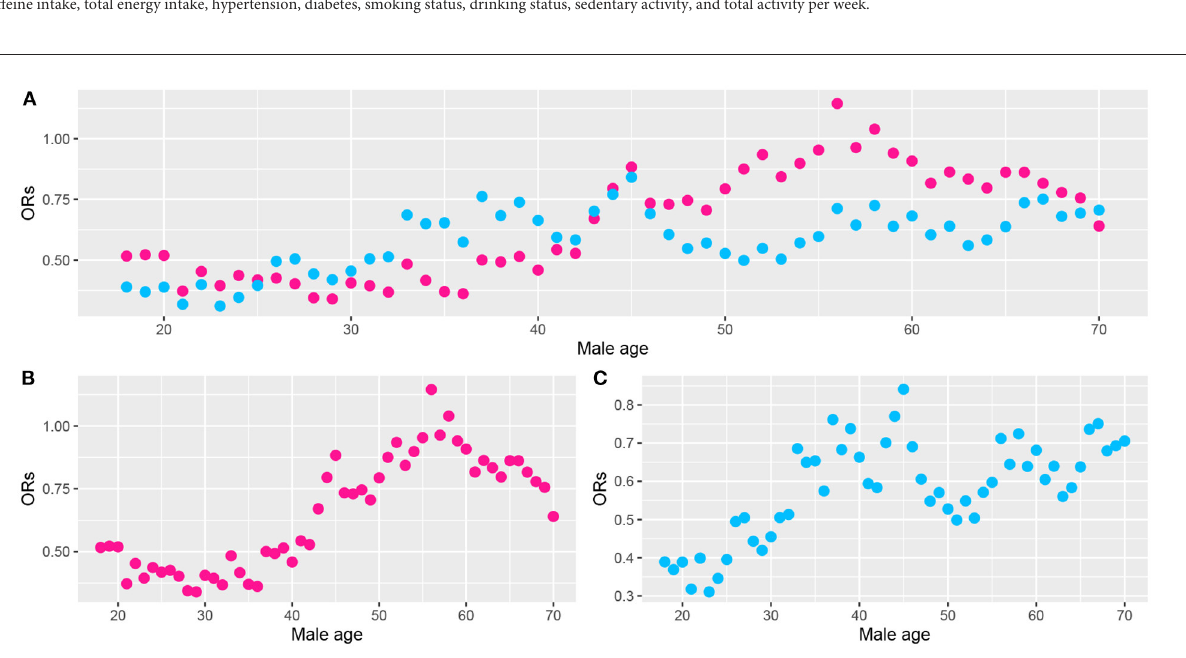
FIGURE4 Scatter plot of the odds ratios (ORs) calculated from male data (aged from 18 to 70) in a rolling window with a 15-year time interval. (B) ORs of men’s very short sleep for the second tertile of ALA intake. (C) ORs for the third tertile. (A) ORs for the second (pink) and the third tertile (skyblue) of ALA intake. Models were adjusted for race, educational level, marital status, annual family income, BMI, caffeine intake, total energy intake, hypertension, diabetes, smoking status, drinking status, sedentary activity, and total activity per